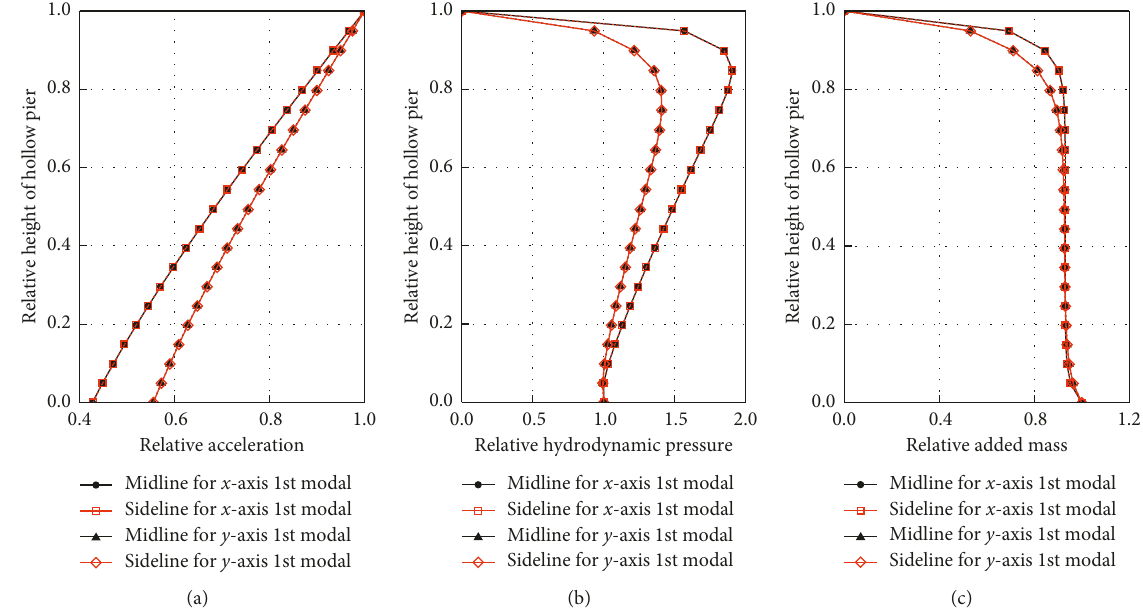
Figure 14: Distribution of relative modal acceleration, relative hydrodynamic pressure, and relative HAM along the specimen without tip mass corresponding to a water level of H w � 1.8 m in case II: (a) relative modal acceleration; (b) relative hydrodynamic pressure; (c) relative HAM.